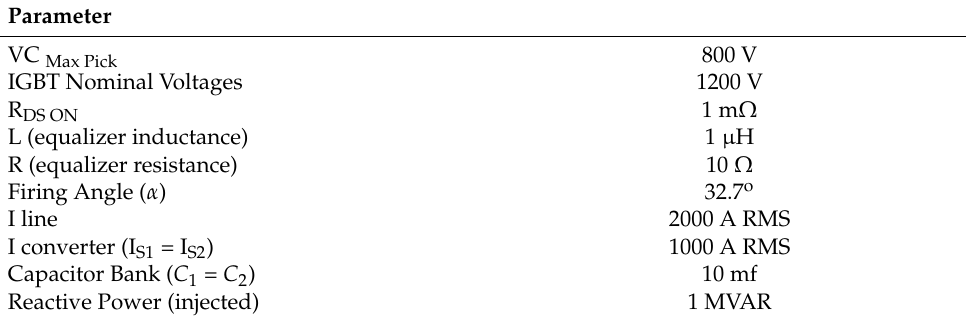
Figure 11. Two SSSC converters diagram. Table 1. Parameter.